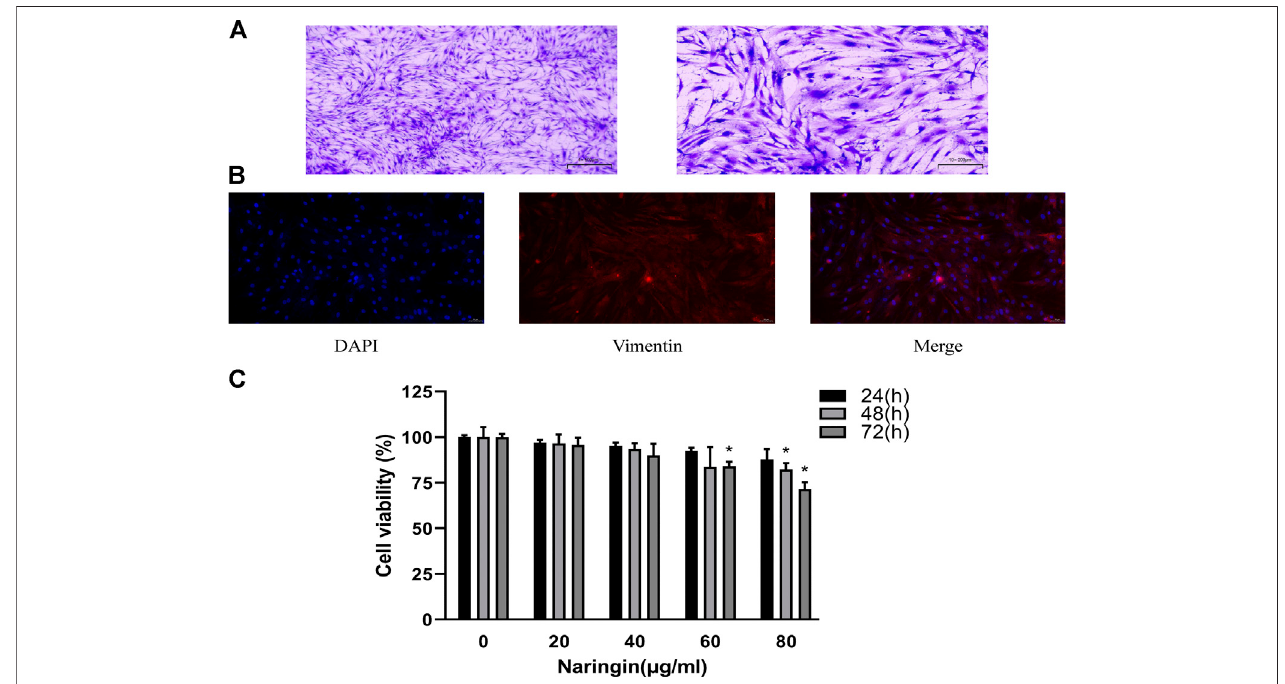
FIGURE 7 | Identi fi cation of RA-FLS and therapeutic effect of naringin. (A) Representative images of RA-FLS stained with 5% crystal violet (100 × , bar scale (cid:1) 100 μ mand200 × ,barscale (cid:1) 50 μ m). (B) Representativeimagesofimmuno fl uorescencestainingforVimentin(200 × ,barscale (cid:1) 50 μ m). (C) Cellviabilitywasmeasured using CCK-8 assay. Naringin reduces cell viability of RA-FLS in a dose-dependent manner. * p < 0.05. Each experiment was repeated for three times in different individuals.